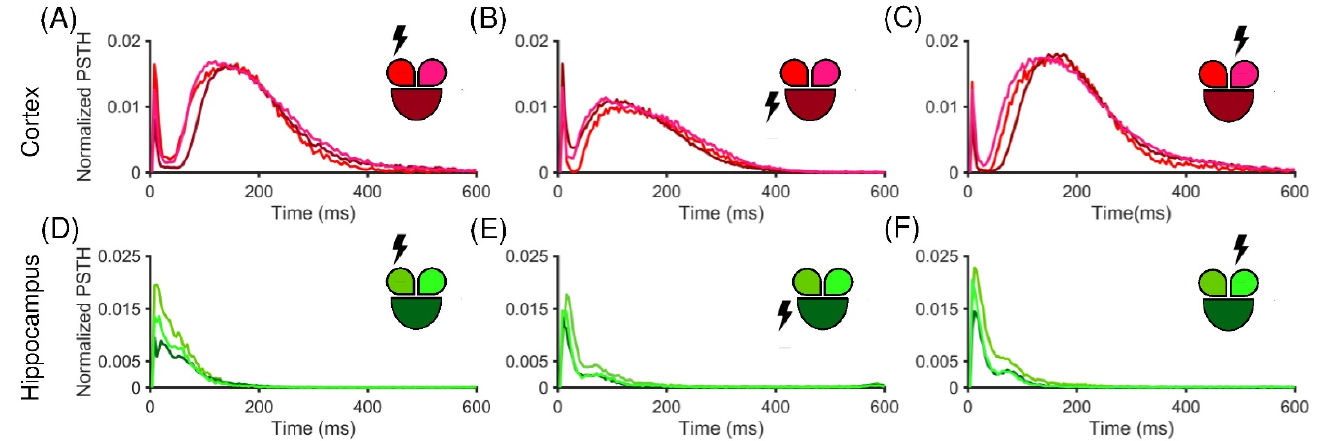
Figure 3. Normalized PSTH traces of a representative cortical ( A – C ) and hippocampal ( D – F ) network. The insets show the color-coded configurations. The stimulated compartment is indicated with a lightning sign in the inset. PSTH generated for ( A ) the small left, ( B ) the big central, and ( C ) the small right stimulated compartment in the cortical configuration. ( D – F ) The hippocampal counterpart in the same conditions.